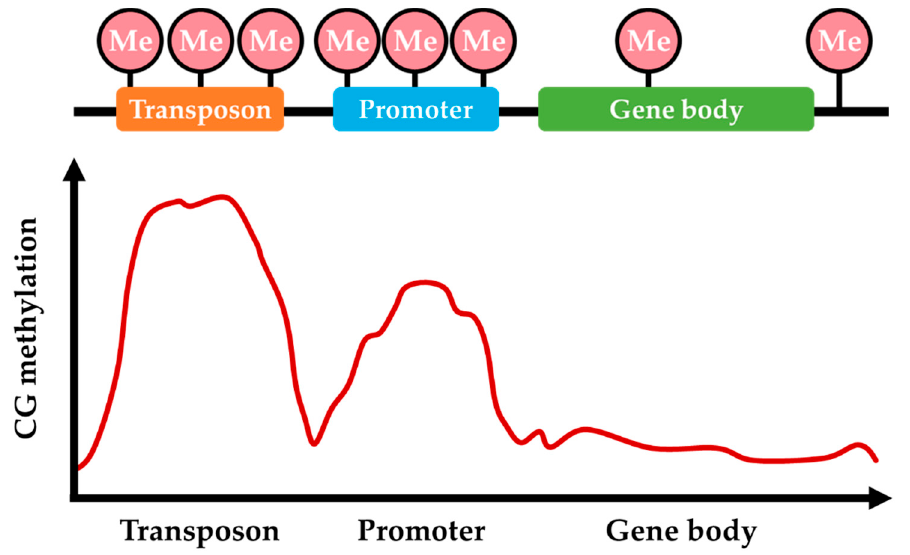
Figure 2. The pattern of DNA methylation in different regions of the fungal genome. Cytosine methylation preferentially distributes in transposons and prompter regions and rarely distributes in gene body and intergenic regions.